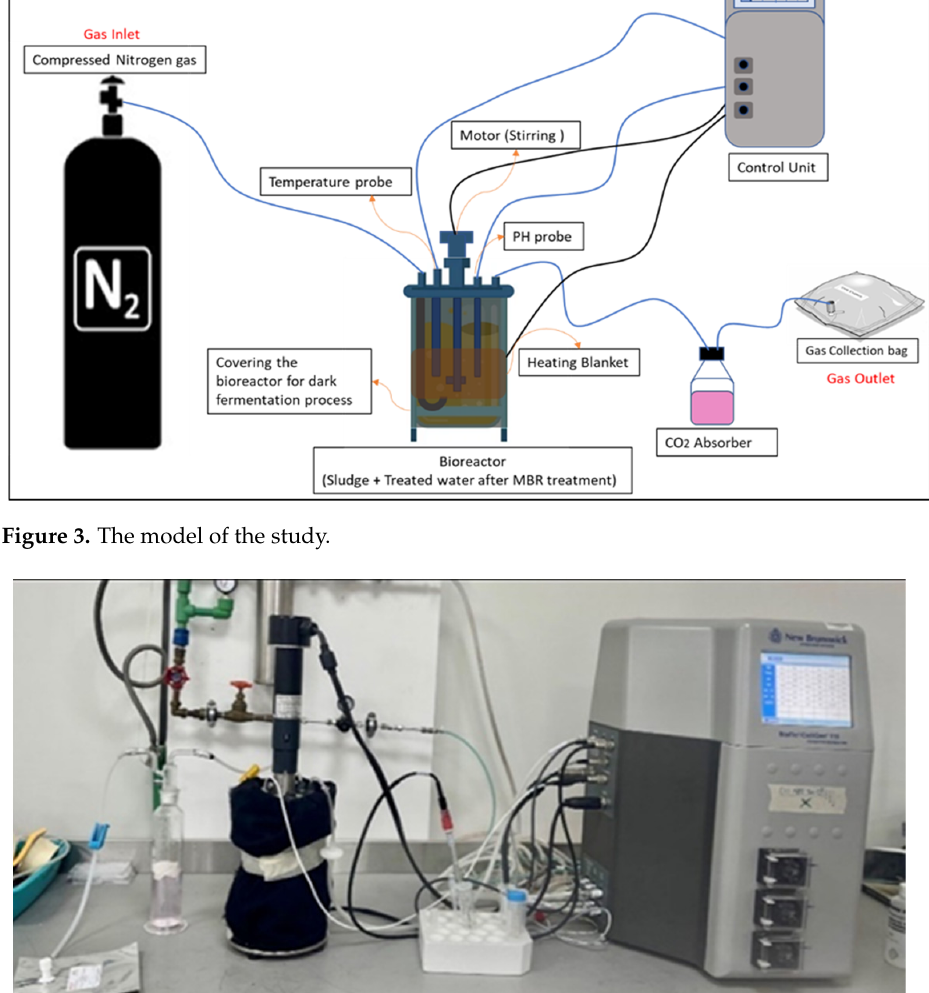
Figure 4. Experimental set-up of the study.